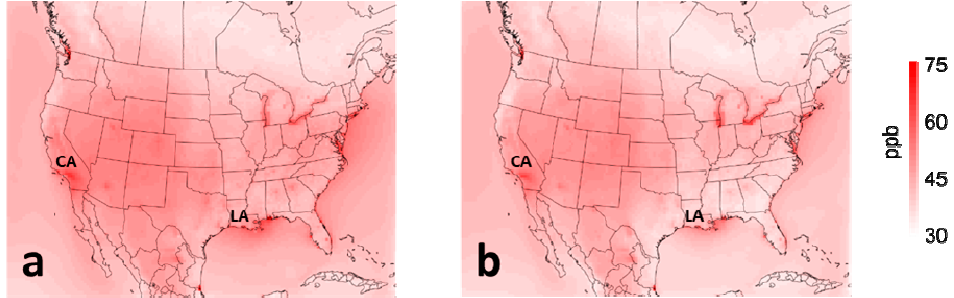
Figure 1. Average of seasonal maximum 8-hour ozone average concentrations across the domain for the Business as Usual (BAU), ( a ) for 2020 and ( b ) 2050 in ppb. California and Louisiana shown on the